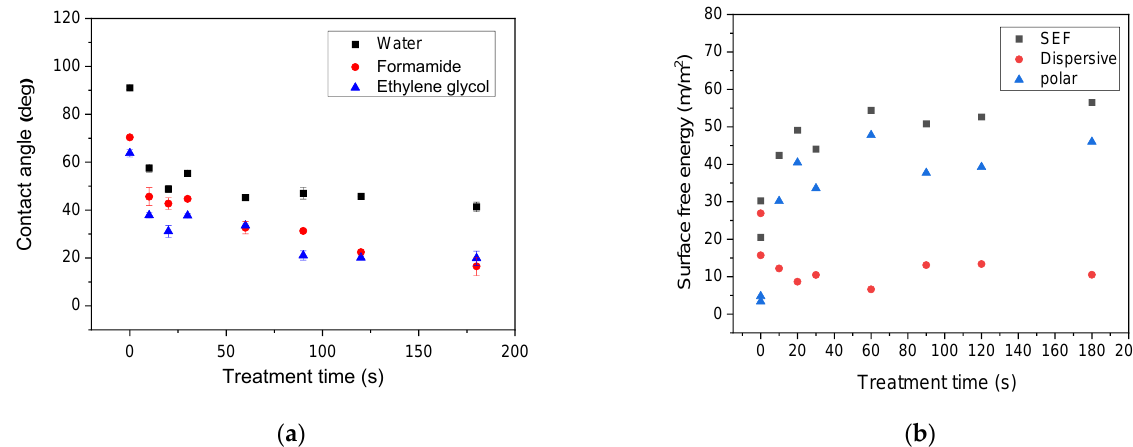
Figure 1. Dependence of ( a ) contact angle and ( b ) surface free energy (SFE) of selected liquids on plasma treated low-density polyethylene (LDPE) foil on treatment time .